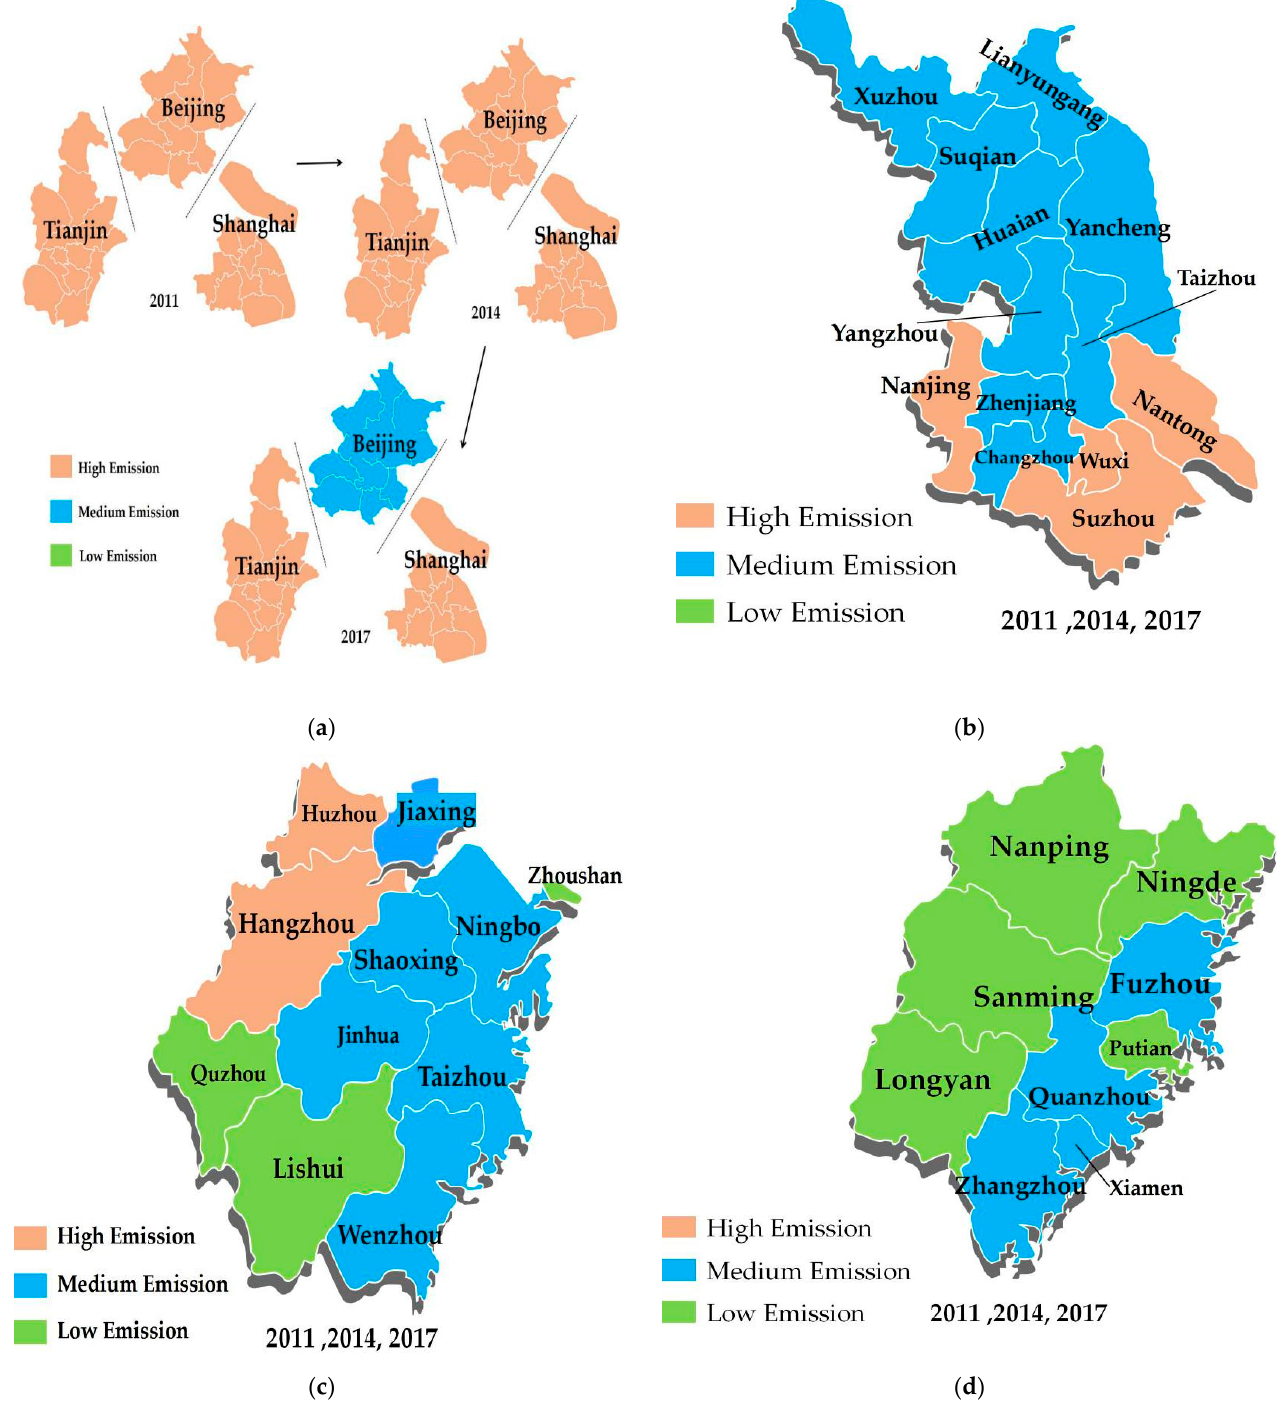
Figure 3. Spatio-temporal evolution map of carbon emissions. ( a ) Beijing, Tianjin and Shanghai. ( b ) Jiangsu Province. ( c ) Zhejiang Province. ( d ) Fujian Province.